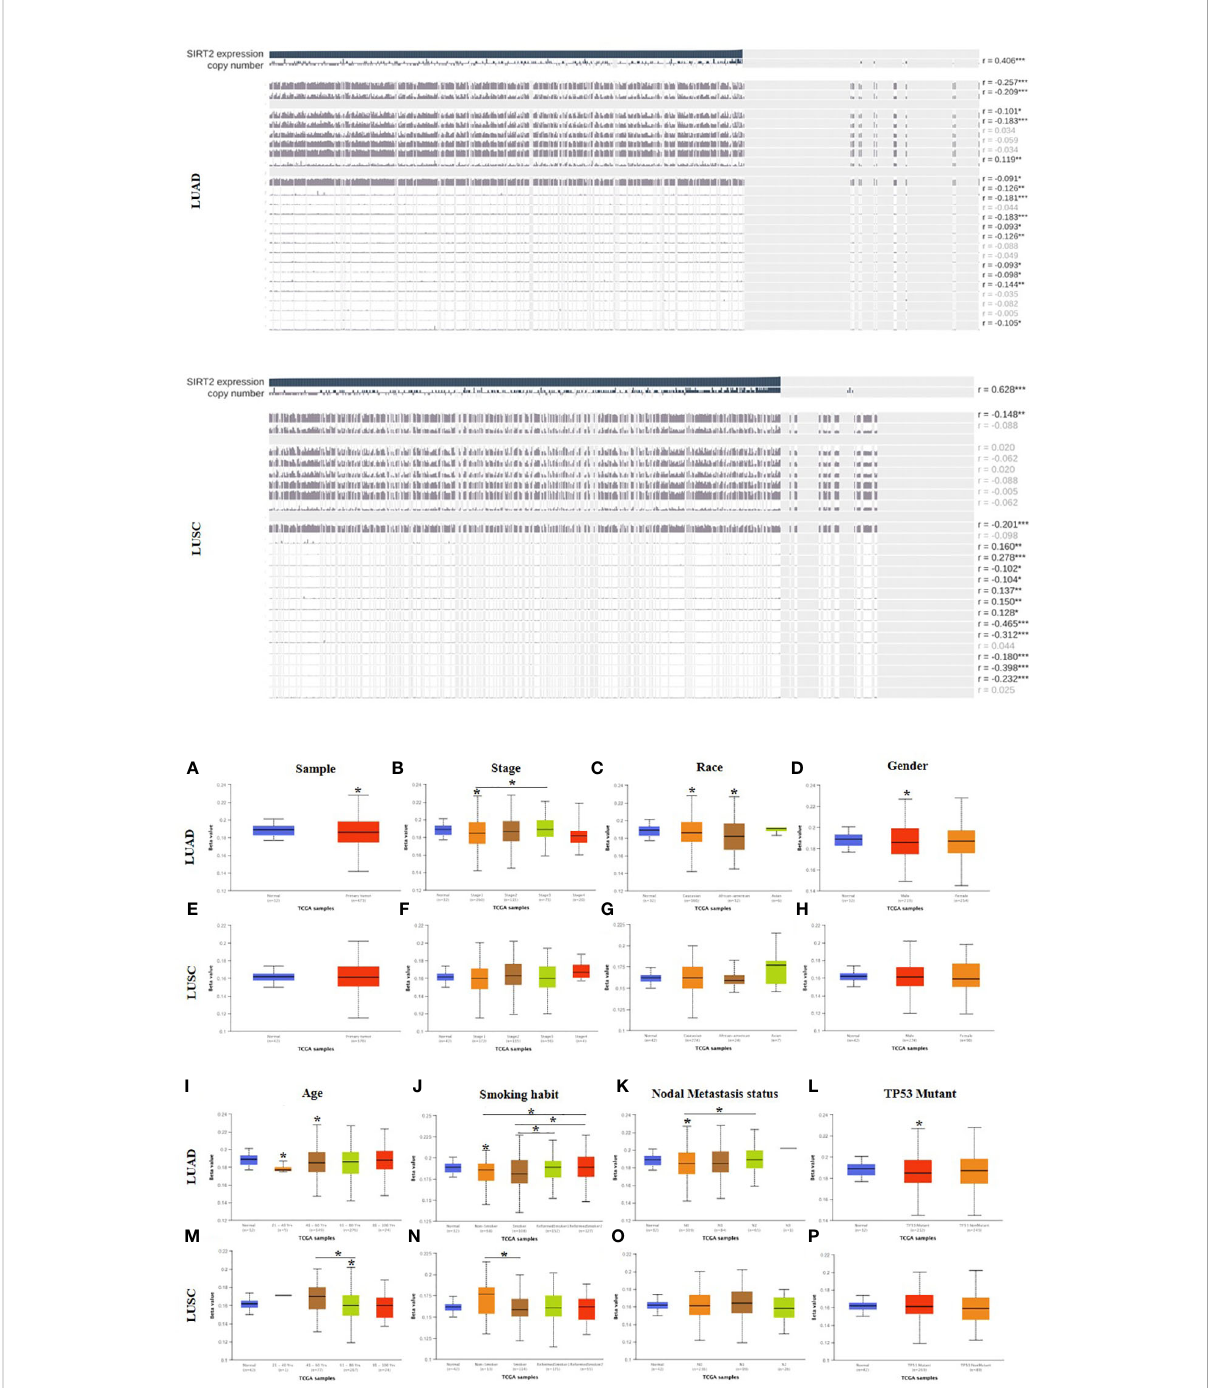
FIGURE 3 Visualization of SIRT2 promoter methylation levels in fl uence the clinicopathological parameters among LUAD and LUSC patient cohorts. Methylation sites prediction using MEXPRESS (upper). Promoter methylation levels of SIRT2 in sample types (A, E) , stage (B, F) , race (C, G) , gender (D, H) , age (I, M) , smoking habit (J, N) , nodal metastasis status (K, O) and TP53 mutant (L, P) in LUAD and LUSC cohorts respectively using UALCAN (lower). * p ≤